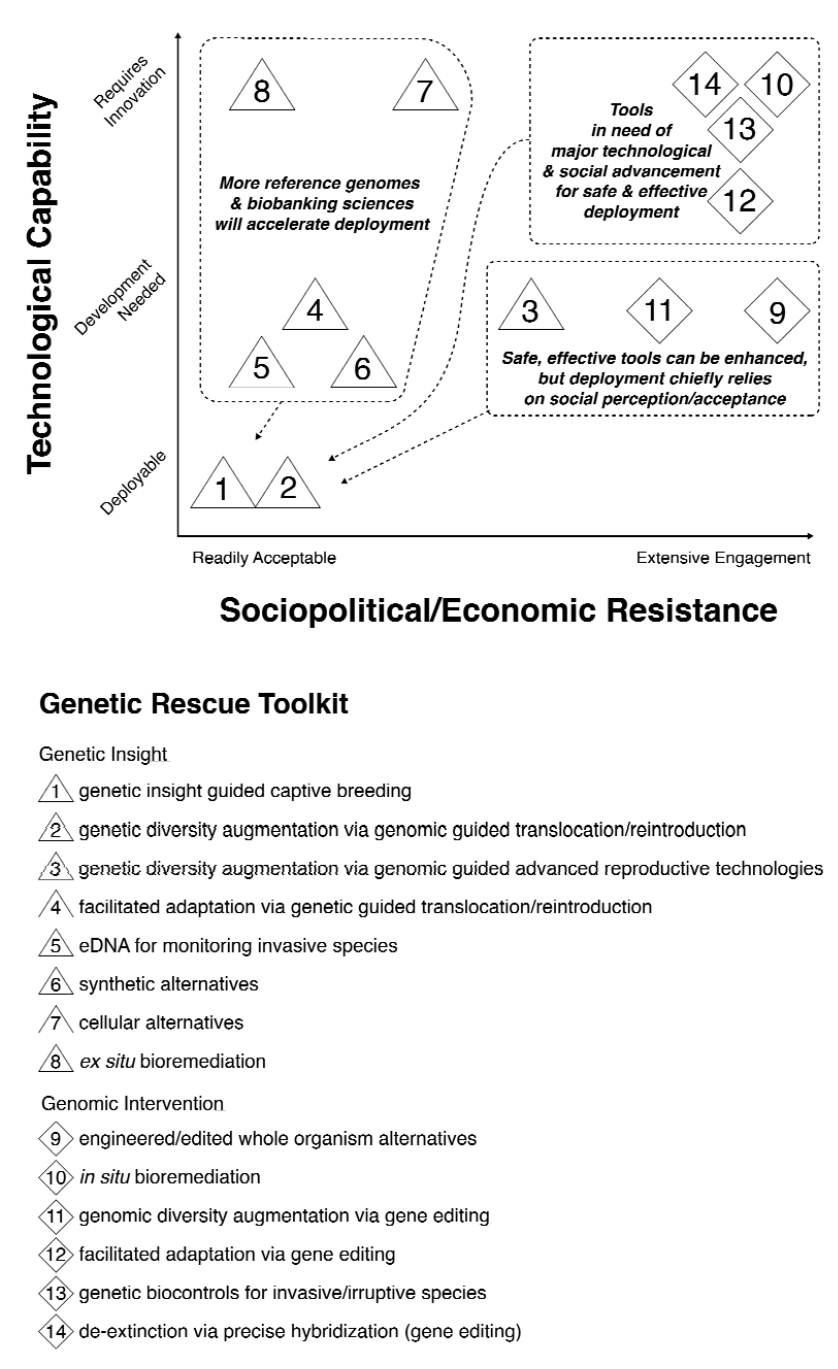
Figure 1. The Genetic Rescue Toolkit Continuum of “Readiness”. A qualitative framework for assessing the technological and sociopolitical / economic factors influencing the readiness and deployment of applications within the Genetic Rescue Toolkit. Triangles denote genetic insight applications and diamonds indicate genomic intervention applications. The sociopolitical / economic axis encompasses consideration of regulations, public perception, cultural influence, and economic factors on the gradient of resistance to use these applications, the left-hand side being acceptable tools and the right-hand being applications met with higher levels of concern. With particular technological developments all these tools can be refined to deployable states, but while social and ethical engagement will improve many tools to acceptable consensus, some tools will face persistent resistance from certain stakeholders for reasons other than safety or e ffi cacy (e.g., ideologies opposing human intervention in